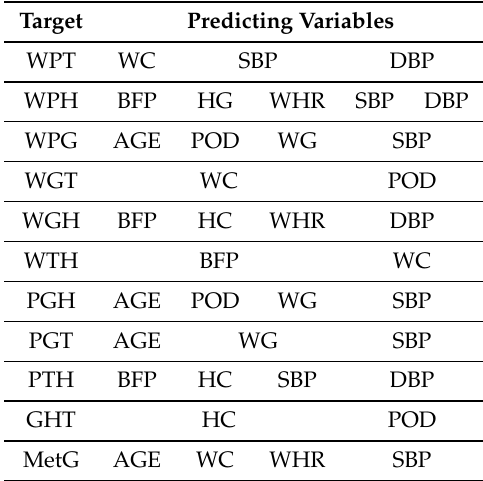
Table 12. Selection of predicting variables for each target from the dataset with oversampling.